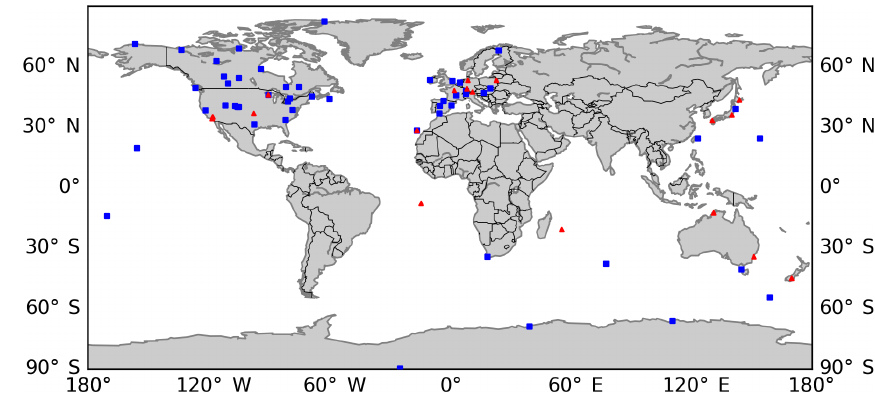
Figure 2. Map of in situ (blue squares) and TCCON (red triangles) stations. Detailed information on each station is provided in Tables A1 and